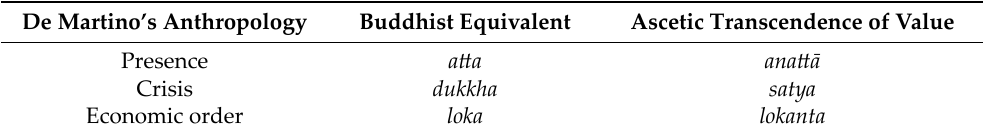
Table 1. Buddhist asceticism compared with De Martino’s